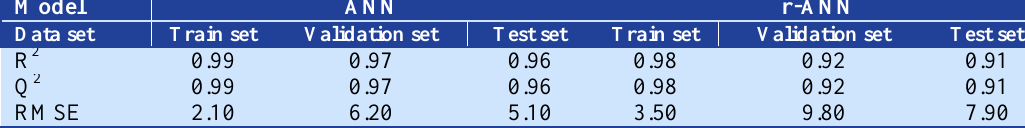
Table 4. Statistical characteristics of the artificial neural network (ANN) model Model ANN r-ANN Data set Train set Validation set Test set Train set Validation set Test set R 2